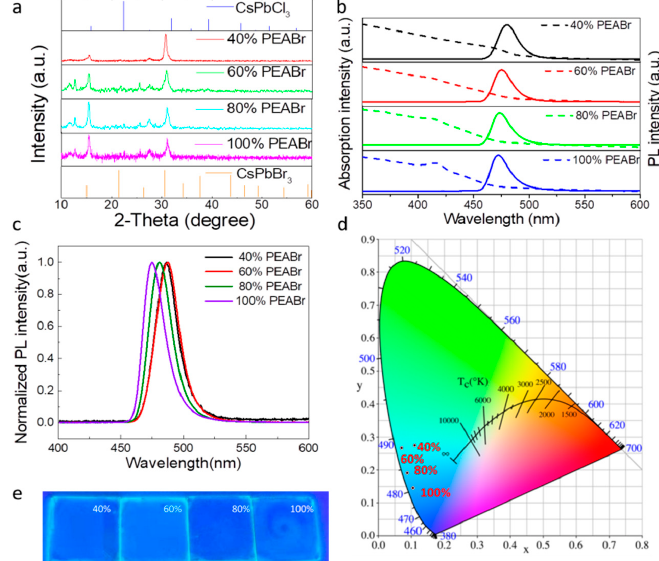
Figure 3. ( a ) XRD patterns, ( b ) absorption and PL spectra, ( c ) normalized PL spectra, and ( d ) corre- sponding CIE of CsPbCl 0.75 Br 2.25 thin films with different ratios of PEABr. ( e ) Images of the blue perovskite films with different ratios of PEABr under 365 nm light